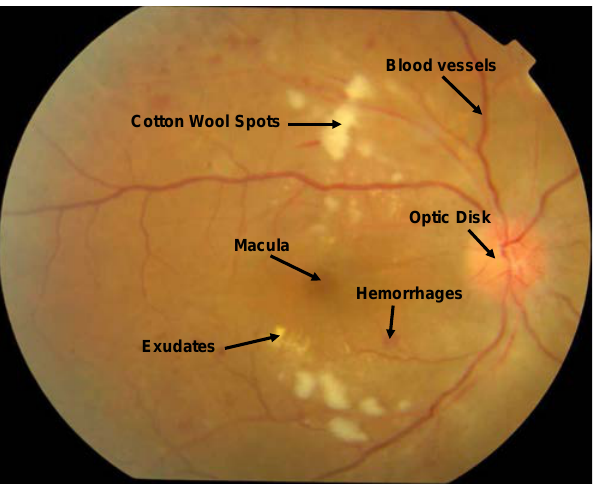
Fig. 1. Sample retinal image with structures and abnormali- ties marked with